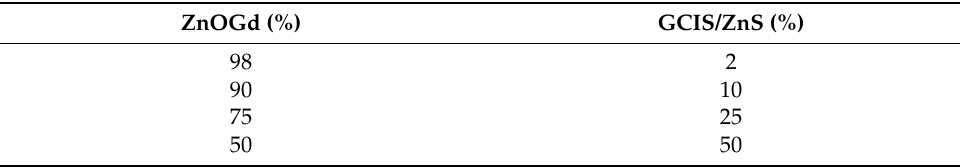
Table 1. Quantum dots (Qdots) proportions used for the conjugation